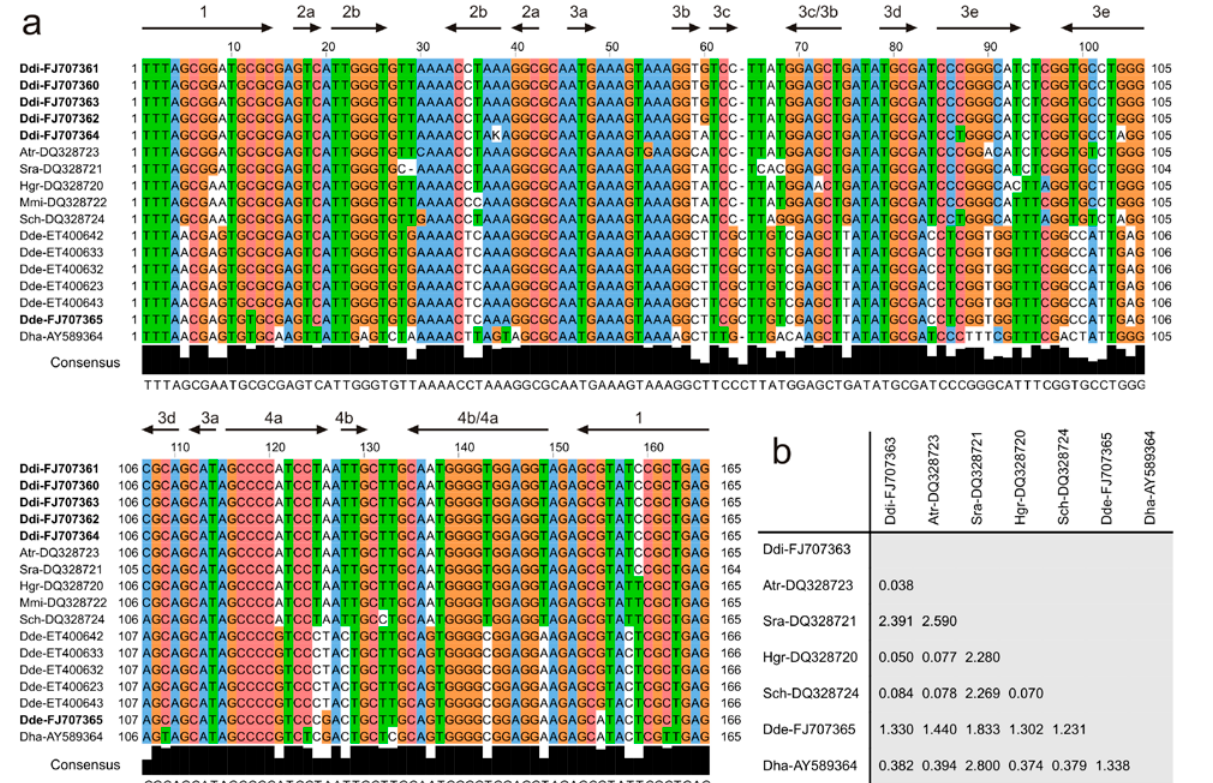
Figure 3. a. Multiple sequence alignment of the D3 LSU 28S rDNA sequences. The label on the left-hand side of each se - quence gives its study code with GenBank accession. The consensus row at the bottom shows the most frequent residue at each row or “+” if two or more residues are equally abundant. Predicted secondary structural elements (helical regions) for the stem nematode Ditylenchus dipsaci are indicated by black arrows ( → or ← ) reported above the sequences; the numbering of helices is the same as in Figure 5a. b. Distance matrix based on the D3-28S rDNA alignment for the selected members of the Anguinidae family. Note: For each matrix, the values are pair-wise p-distances, which represent the divergence of all bases between two sequences. Nematode species abbreviations are as in Figure 2. The number following species abbrevia- tion at each nucleotide sequence represents GenBank accession